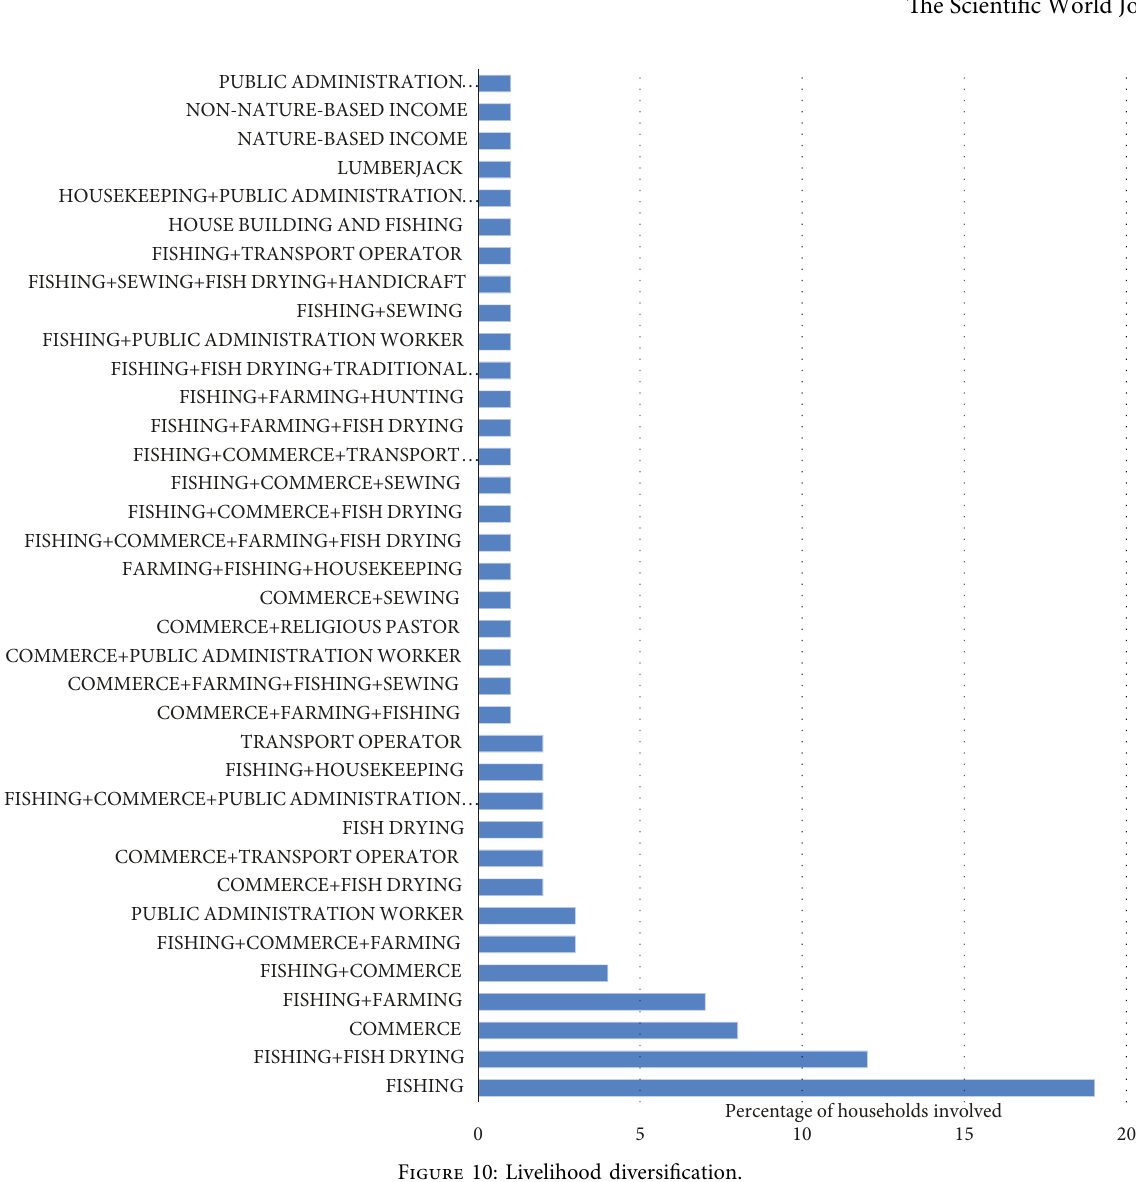
Figure 10: Livelihood diversification.